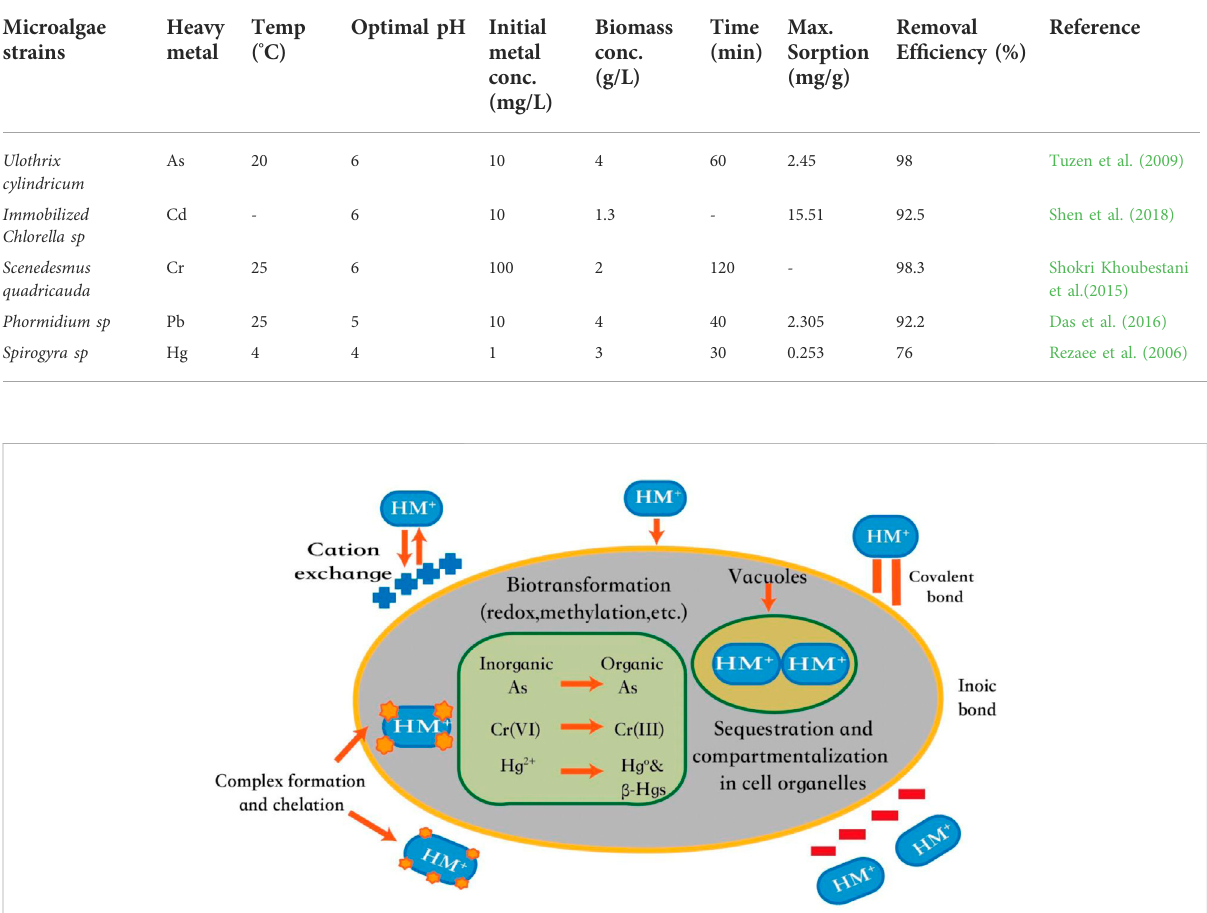
TABLE 3 The ability of microagae for the removal of heavy metals from aqueous solutions (Leong and Chang, 2020).